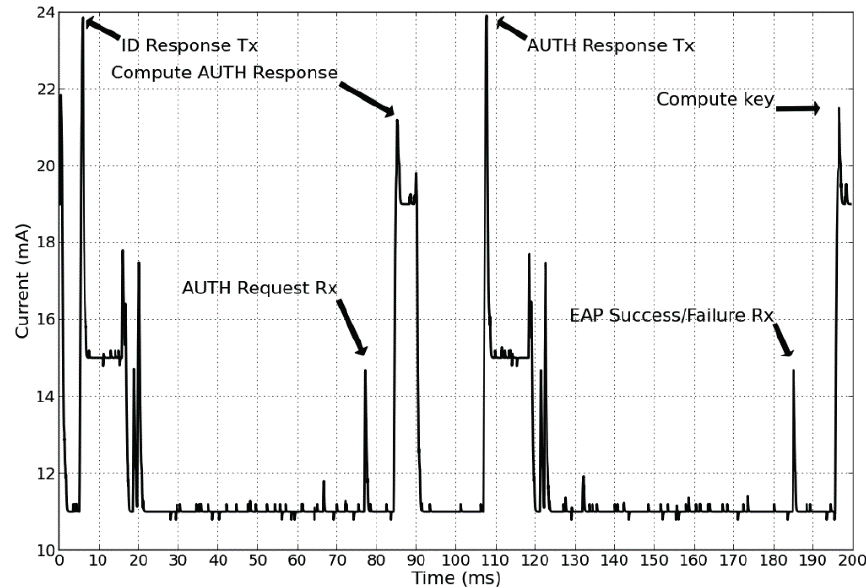
Figure 7. Current consumption by the sensor node during one full authentication procedure using the MD5-based version of